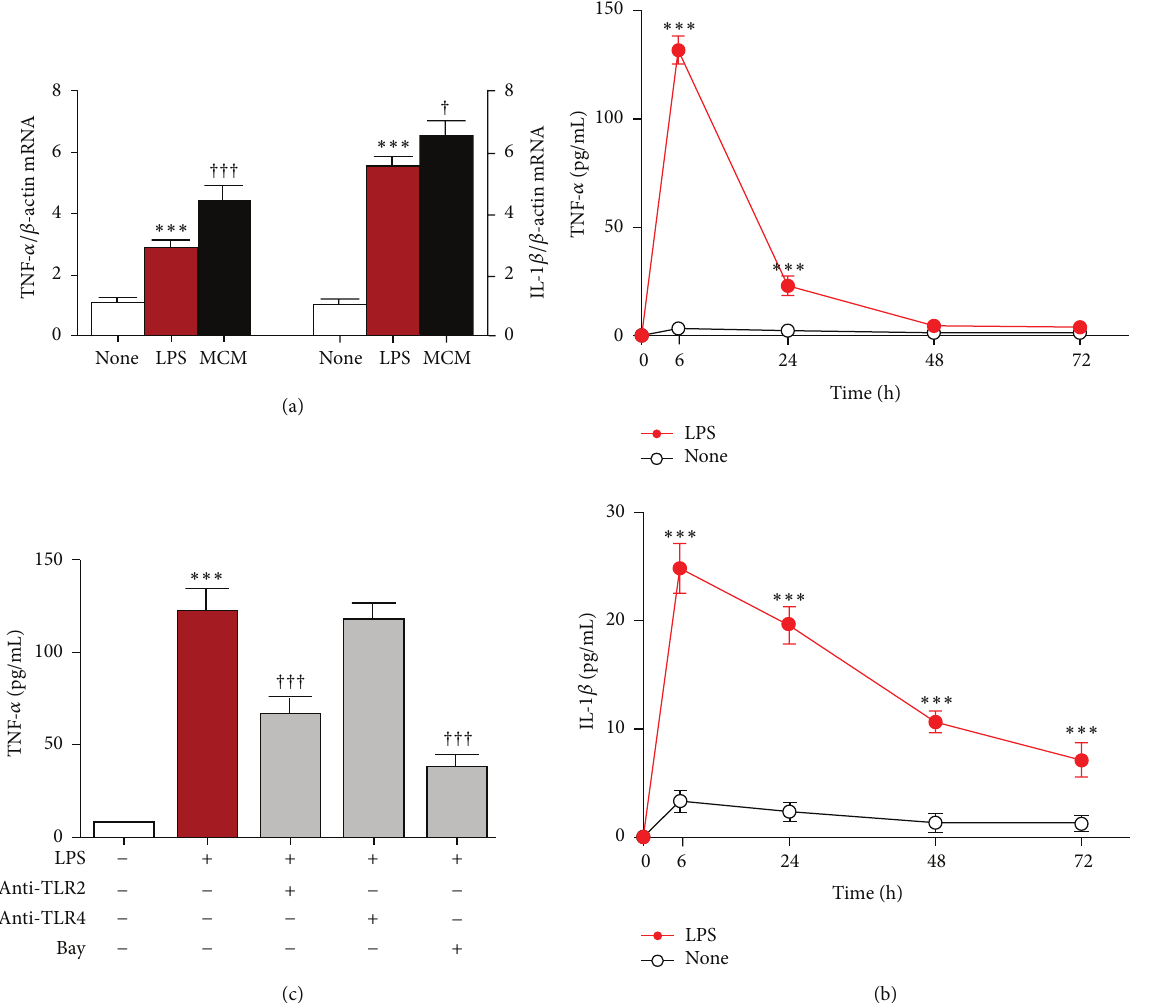
Figure 2: Secretion of proinflammatory mediators by leptomeningeal cell after treatment with the conditioned medium from P.g. LPS-treated macrophages and P.g. LPS. The mean mRNA levels of TNF- 𝛼 and IL-1 𝛽 of leptomeningeal cells at 4h incubated with P.g. LPS (LPS) and conditionedmediumof P.g. LPS-treatedRAW264.7mousemacrophages(MCM)(a).Dataarepresentedbymean ± SEM( 𝑛 = 3 ), ∗∗∗ 𝑃 < 0.001 versus nontreated cells (none). ††† 𝑃 < 0.001 versus P.g. LPS alone. Time course of TNF- 𝛼 and IL-1 𝛽 secreted by leptomeningeal cells after treatmentwith P.g. LPS(100 ng/mL)(b).Dataarepresentedbymean ± SEM( 𝑛 = 4 ,each), ∗∗∗ 𝑃 < 0.001 versusnontreatedcells(none).The P.g. LPS-induced TNF- 𝛼 secretion by leptomeningeal cells at 6h with the neutralizing antibodies against TLR2 (10 𝜇 g/mL), TLR4 (10 𝜇 g/mL), or Bay 11-7082 (Bay, 20 𝜇 M) (c). Data are presented by mean ± SEM ( 𝑛 = 4 , each), ∗∗∗ 𝑃 < 0.001 versus nontreated cells (none), and ††† 𝑃 < 0.001 versus P.g. LPS